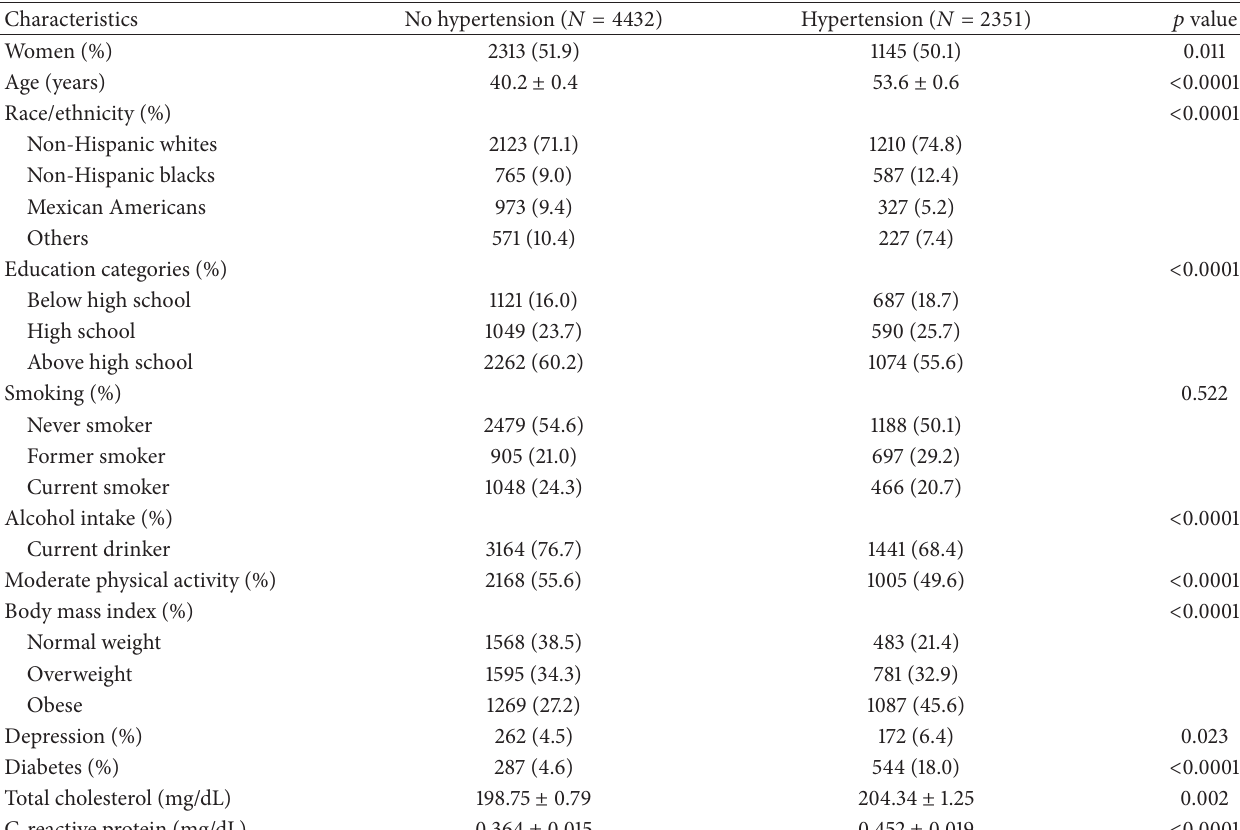
Table 1: Baseline characteristics of the study population *